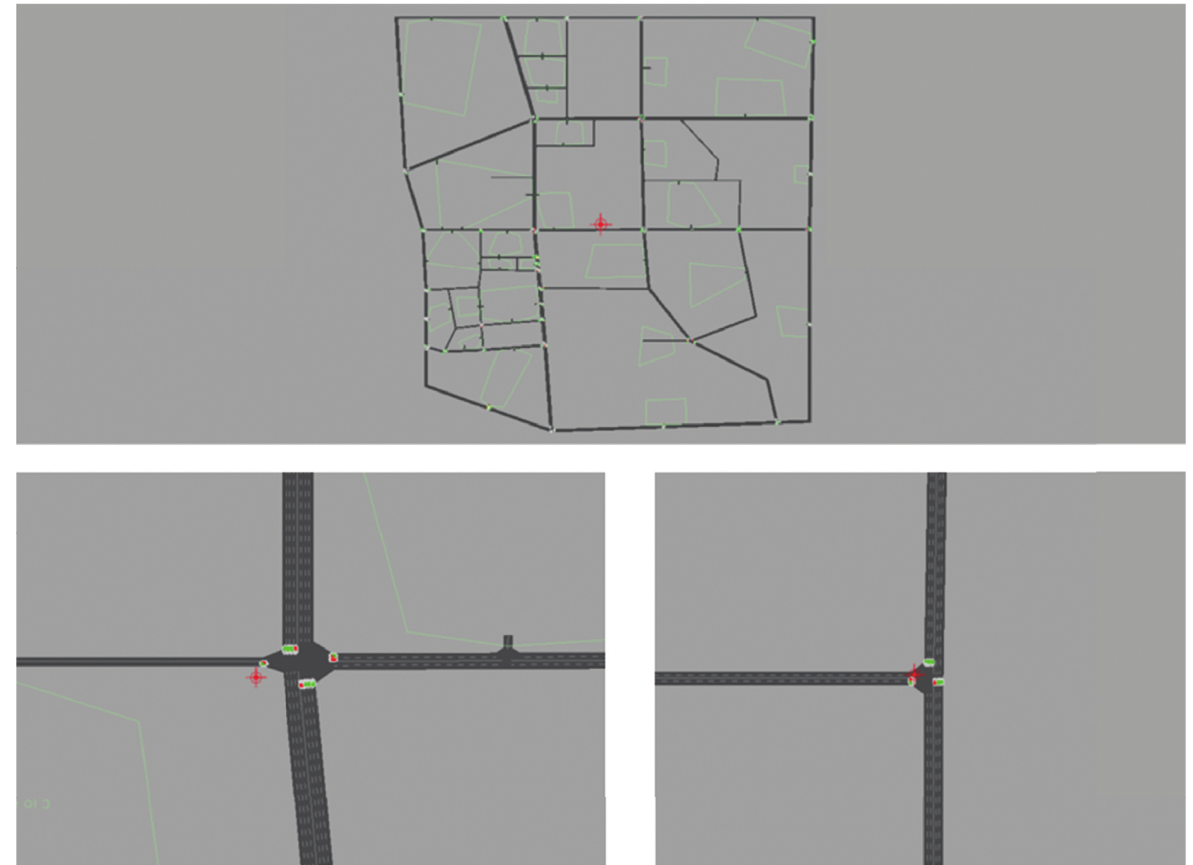
Figure 3: Road network of traffic simulation